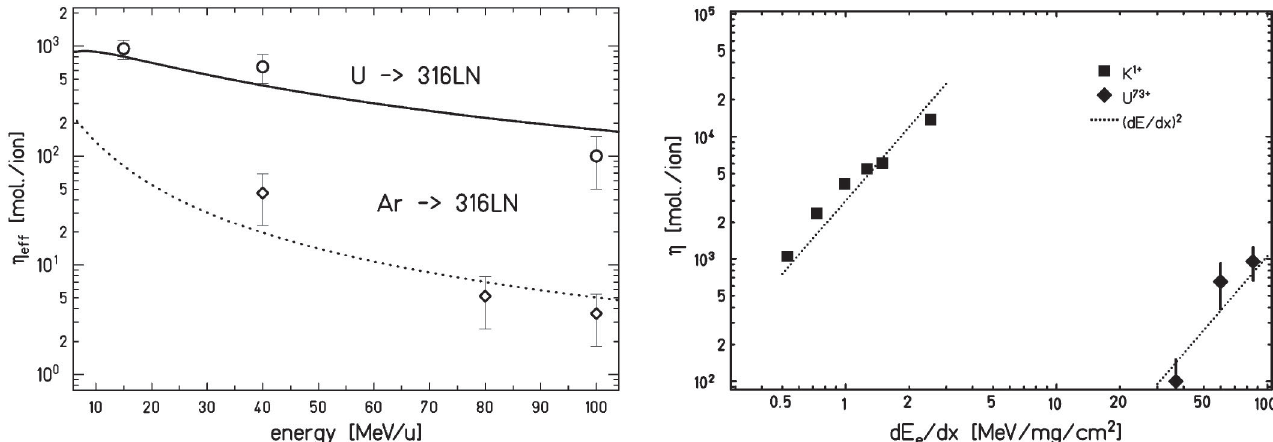
FIG. 4. Left: Desorption yields (points) versus ion energy measured for high-energy U 73 þ and Ar 10 þ ions impacting perpendicularly onto 316LN stainless steel targets. For comparison, the calculated and scaled electronic energy losses ð dE=dx Þ 2 are shown for both projectile-target systems (lines) [36,46]. Right: Desorption yields (points) versus electronic energy loss (dashed lines) measured for low-energy K þ and high-energy U 73 þ ions; square points: data for K þ ions with energies between 70 and 1000 keV impacting under grazing angle ( (cid:2) ¼ 84 : 0 (cid:5) – 85 : 5 (cid:5) ) onto stainless steel; diamond points: SIS 18 data for U 73 þ ions with energies 15, 40, and 100 MeV = u impacting perpendicularly ( (cid:2) ¼ 0 (cid:5) ) onto stainless steel. The dashed curves indicate the power law ( n ¼ 2 ) for the electronic component of dE=dx [37].